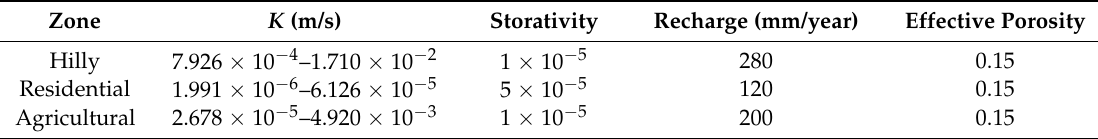
Table 11. The input values of the hydraulic parameters for the different zones.